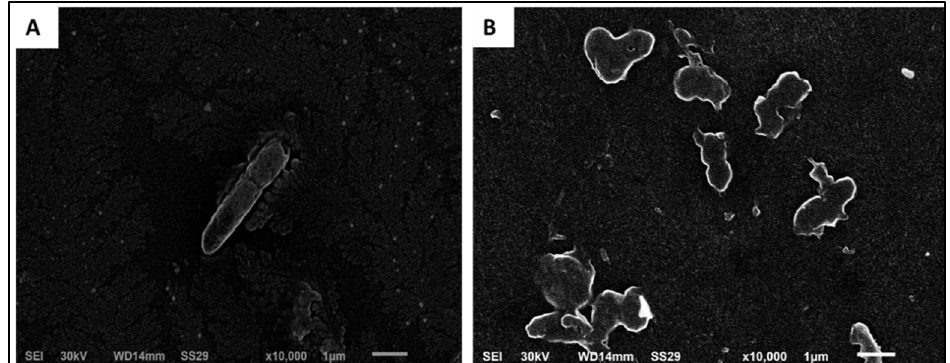
Figure 11. Scanning electron micrographs of representative K. pneumoniae isolates ( A ) before and ( B ) after treatment with F2 bilosomes.